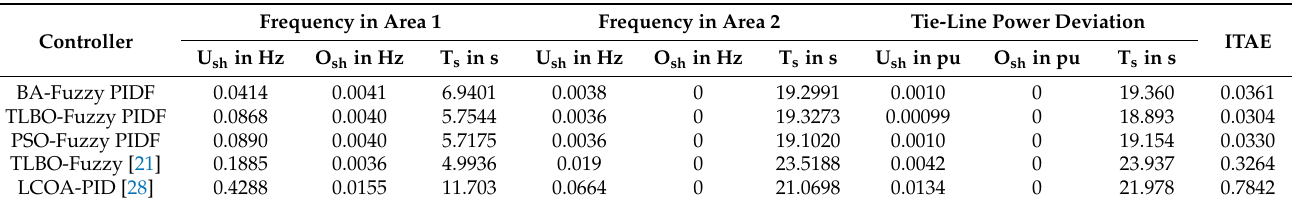
Table 6. Characteristics of the testbed system with several controllers.